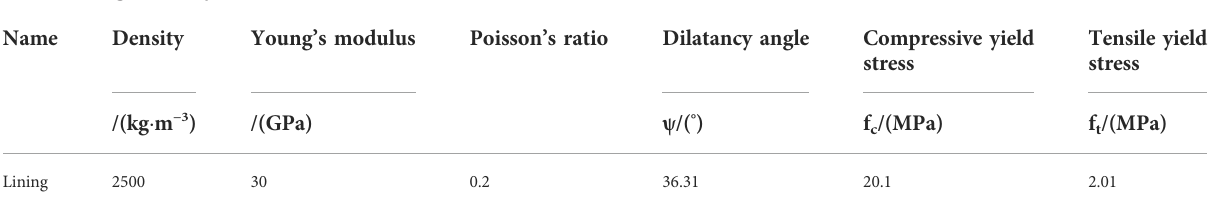
TABLE 2 Lining material parameters used in